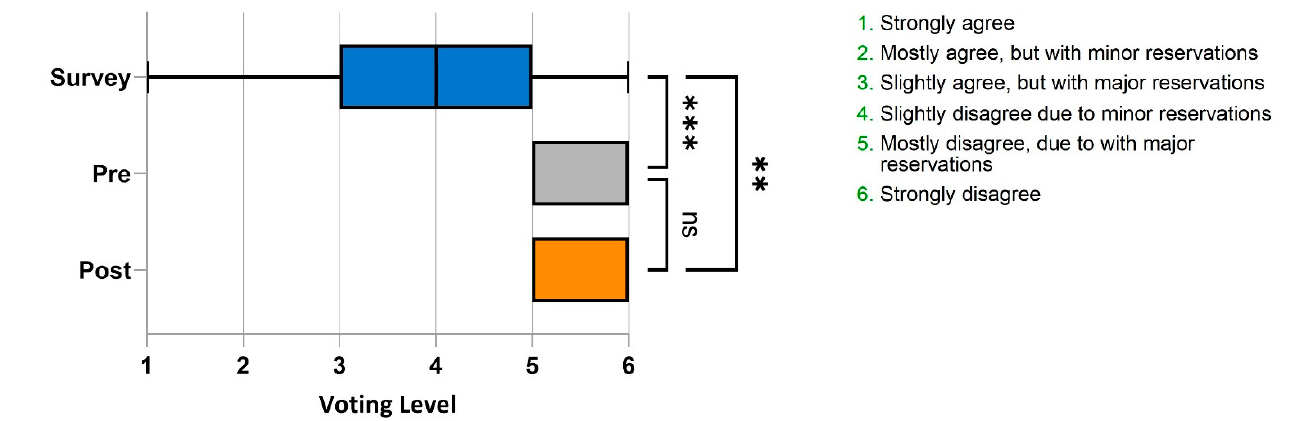
Figure 2. Median voting level for National Survey participants (blue bar, n = 508) and Panelists pre- (grey bar, n = 7) and post-presentation (orange bar, n = 7) for the statement “ Whenever chronic insomnia is associated with another condition, such as anxiety or depression, that psychiatric condition should be the only focus of treatment as the insomnia is most likely a symptom of the condition ”. The grading on the x-axis corresponds to the levels of support/rejection of the statement, with interquartile ranges and anova p values as shown. *** denotes a significant a statistically significant p value of 0.0007; ** denotes a significant p value of 0.0017. ns denotes a non-significant difference in values.